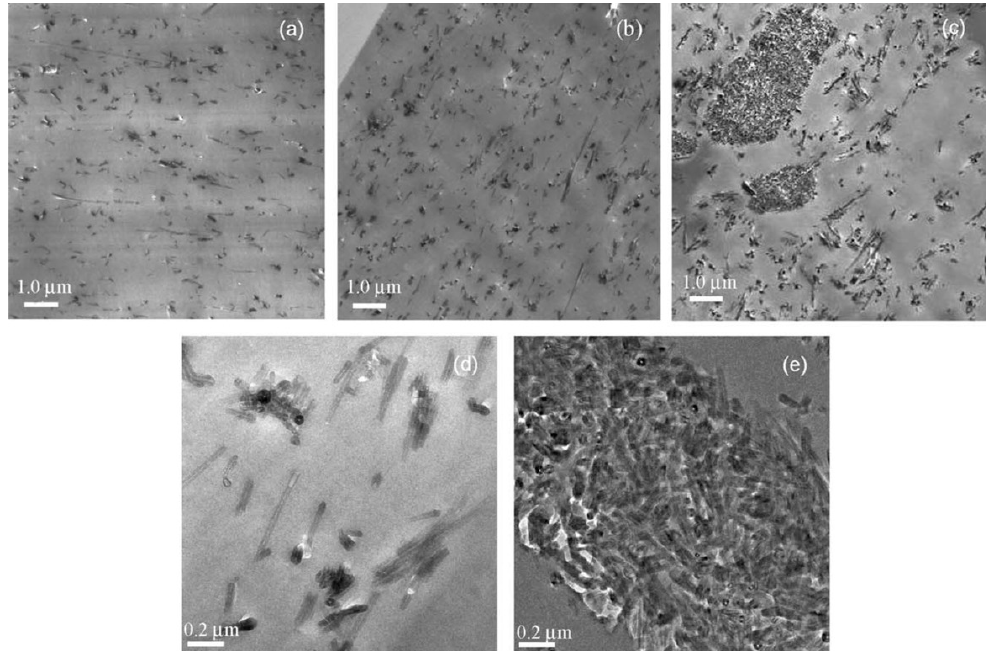
Figure 20. TEM micrographs of microtomed nanocomposites containing various NT loadings: ( a ) 2.2% (vol/vol); ( b ) 4.5% (vol/vol); ( c ) 7.7% (vol/vol)—low magnification; ( d ) 4.5% (vol/vol)